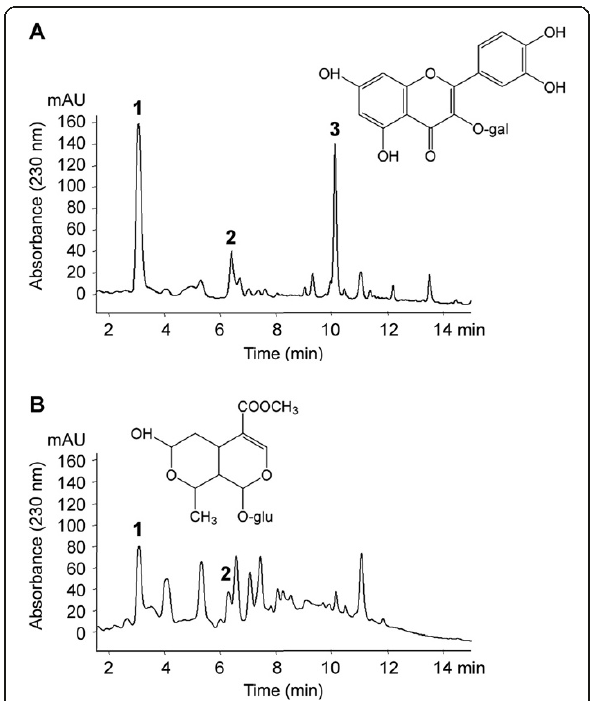
Figure 5 HPLC chromatograms of Sarracenia purpurea leaf and root extracts. Chromatograms of ethanolic leaf ( A ) and root ( B ) extracts with diode array detection at 230 nm wavelength. Labelled peaks represent the marker compounds morroniside (1), epicatechin (2), and hyperoside (3). The structures of the identified active metabolites (1 , 3) are shown with quantitative results reported